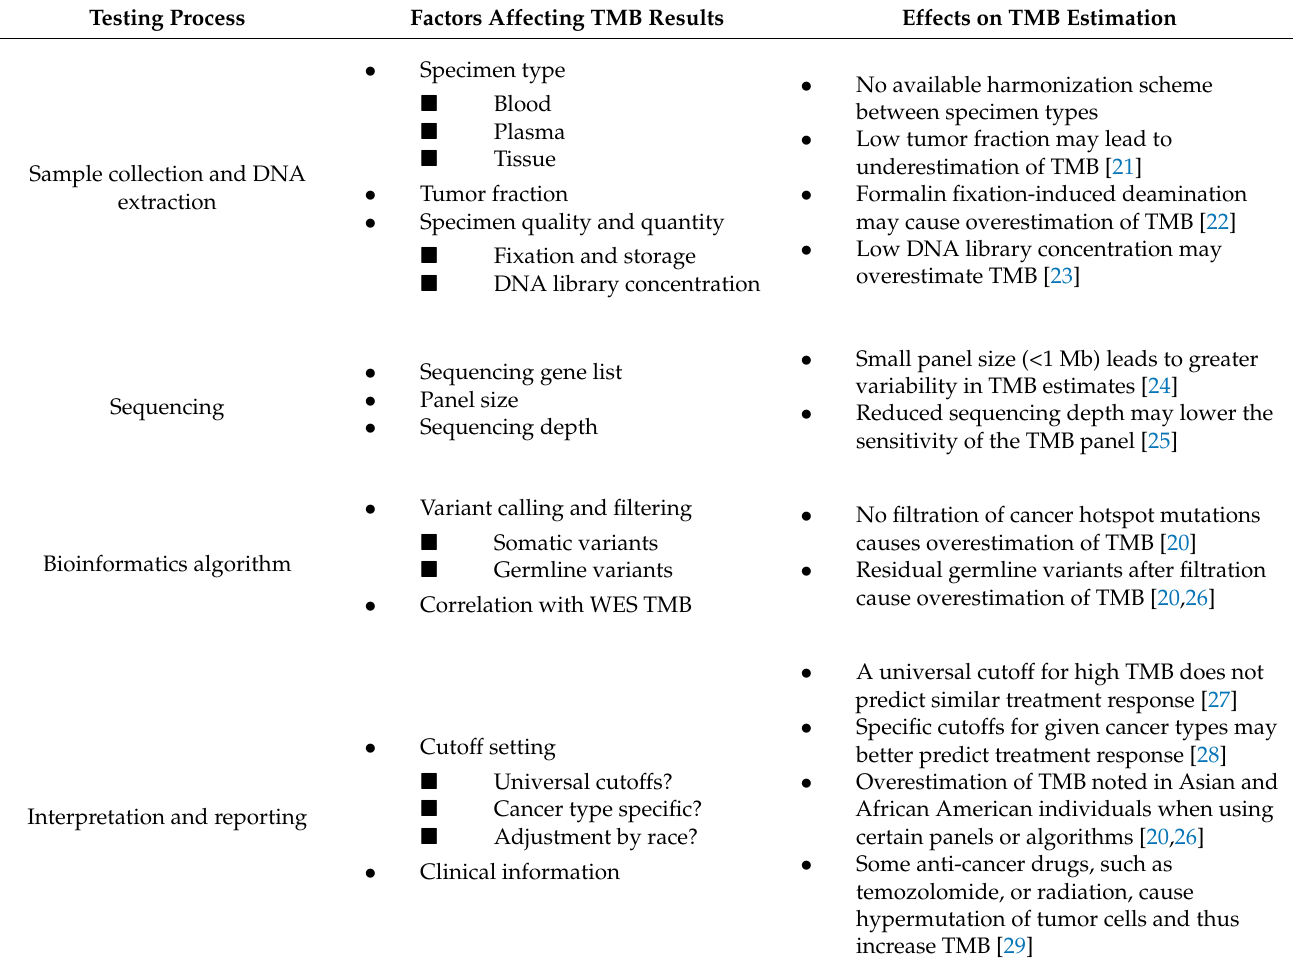
Table 2. Factors affecting TMB